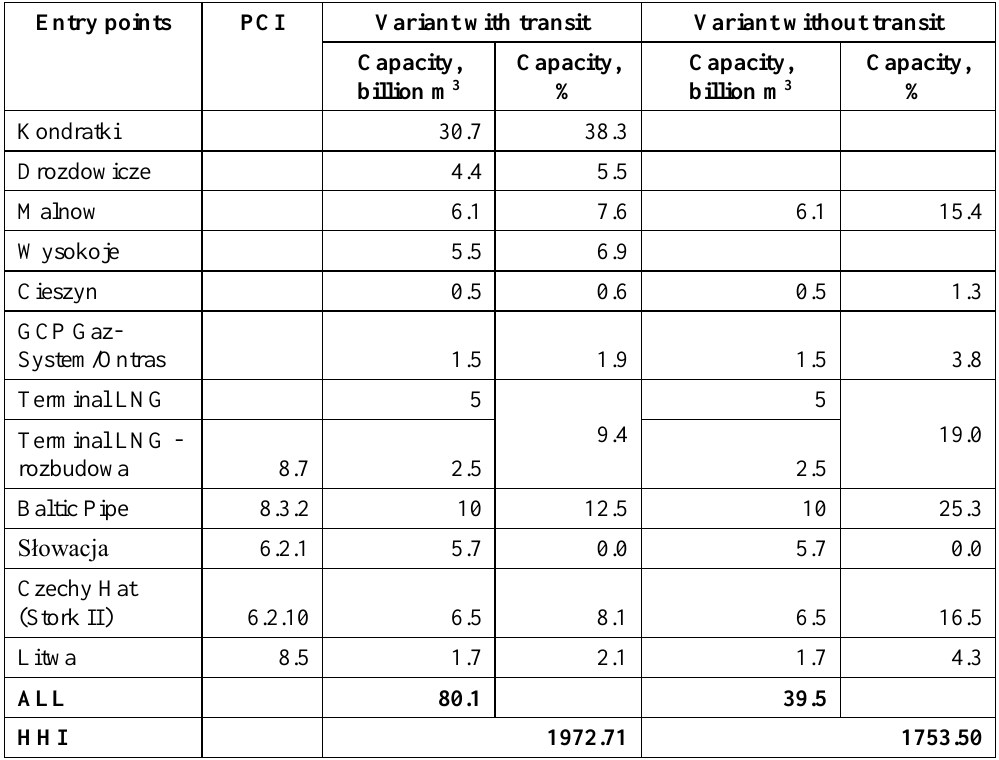
Table 4. Planned Capacity for Natural Gas Import in Perspective of 2022, in Billion m 3 (developed by the